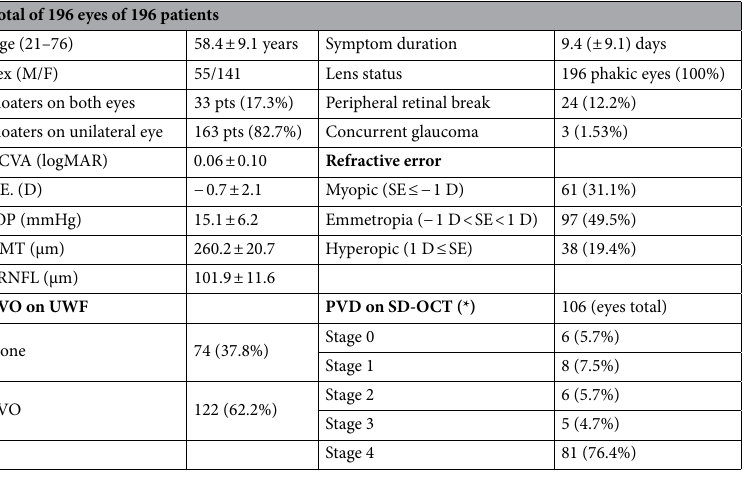
Table 1. Demographics and ophthalmological outcomes of eyes with acute subjective vitreous floaters occurred within 1 month. Demographics and ophthalmological outcomes of eyes with the first occurrence of acute subjective vitreous floaters that developed within a month. *SD-OCT data for 106 eyes (54%) of the total cohort were available. M male, F female, pts patients, BCVA best-corrected visual acuity, logMAR the logarithm of the minimal angle of resolution, SE spherical equivalents, D diopter, IOP intraocular pressure, CMT central macular thickness, pRNFL peripapillary retinal nerve fiber layer, pVO peripapillary vitreous opacity, UWF ultra-widefield scanning laser ophthalmoscopy, PVD posterior vitreous detachment, SD-OCT spectral-domain optical coherence